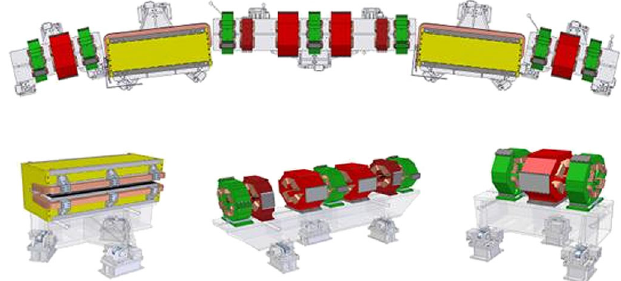
FIG. 2. Layout of magnets and support girders showing adjust- ment points. The top image shows a top view of the arc sector magnets. The bottom image illustrates the three types of support girder and adjustable supports used in the storage ring.